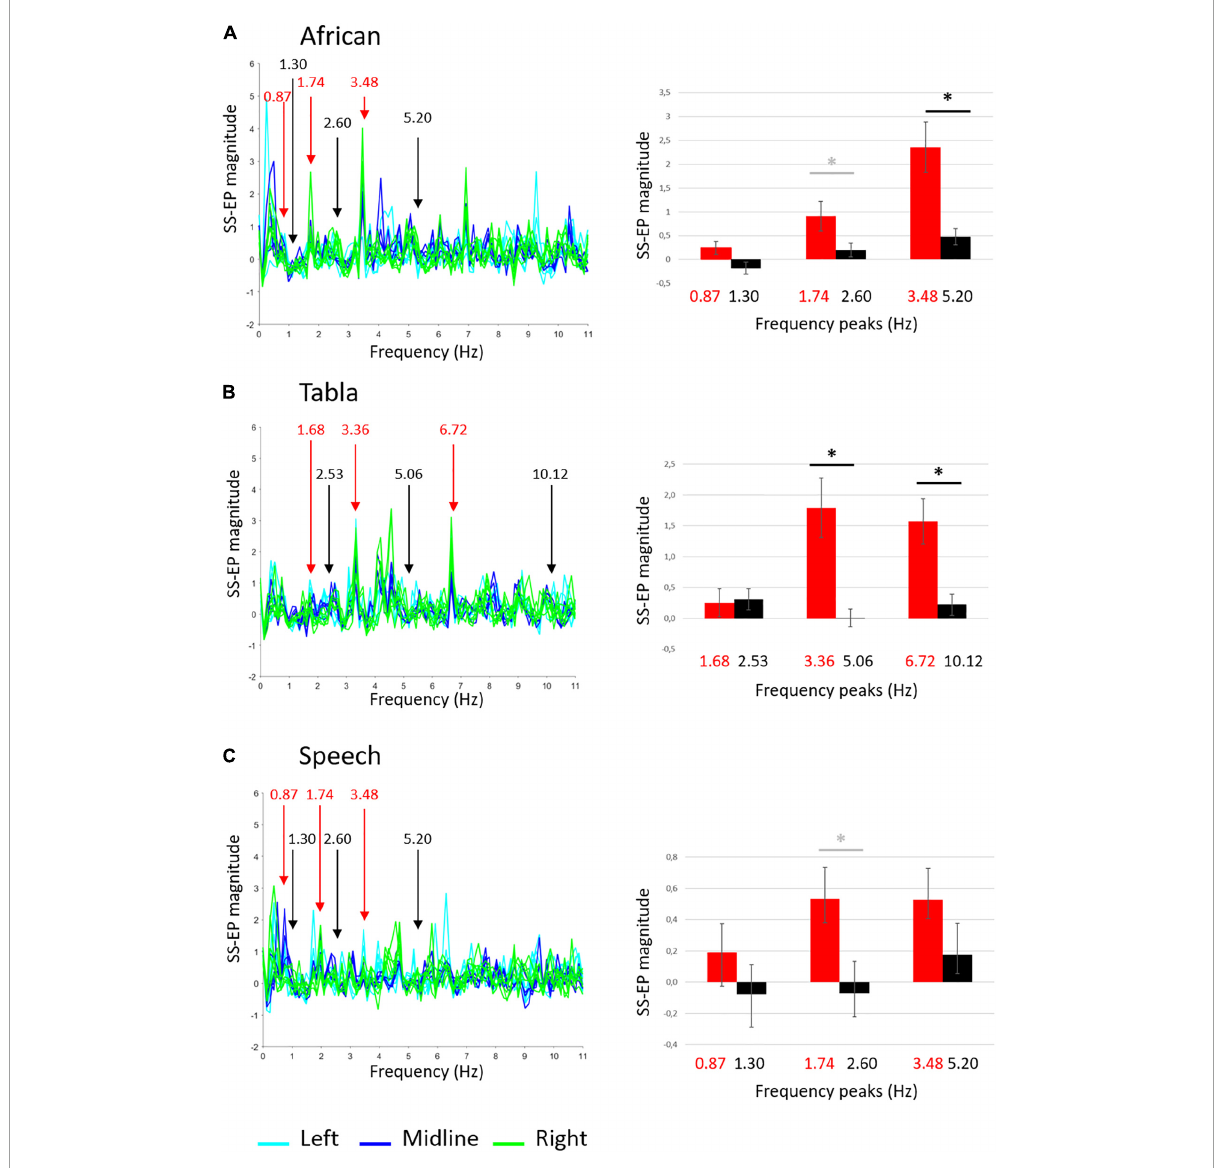
FIGURE2 Group-level average SS-EPs for the three sound stimuli: (A) African musical stimulus; (B) Tabla musical stimulus; (C) Speech stimulus. On the left, butterfly plot of SS-EPs obtained applying the Signal-to-Noise correction ( x -axis: frequency; y -axis: SS-EP magnitude). All EEG channels included in the clusters are plotted (Left: light blue lines, Midline: blue lines, Right: green lines). Peaks at frequencies corresponding to the rhythm envelope are highlighted in red, whereas peaks at frequencies not corresponding to the rhythm envelope, considered as noise floor, are highlighted in black. On the right, bar graphs (error bars indicate SEM) show the averaged SS-EP magnitude. Significant paired t -tests are indicated by black asterisks, whereas differences not surviving False discovery rate (FDR) correction are indicated by gray